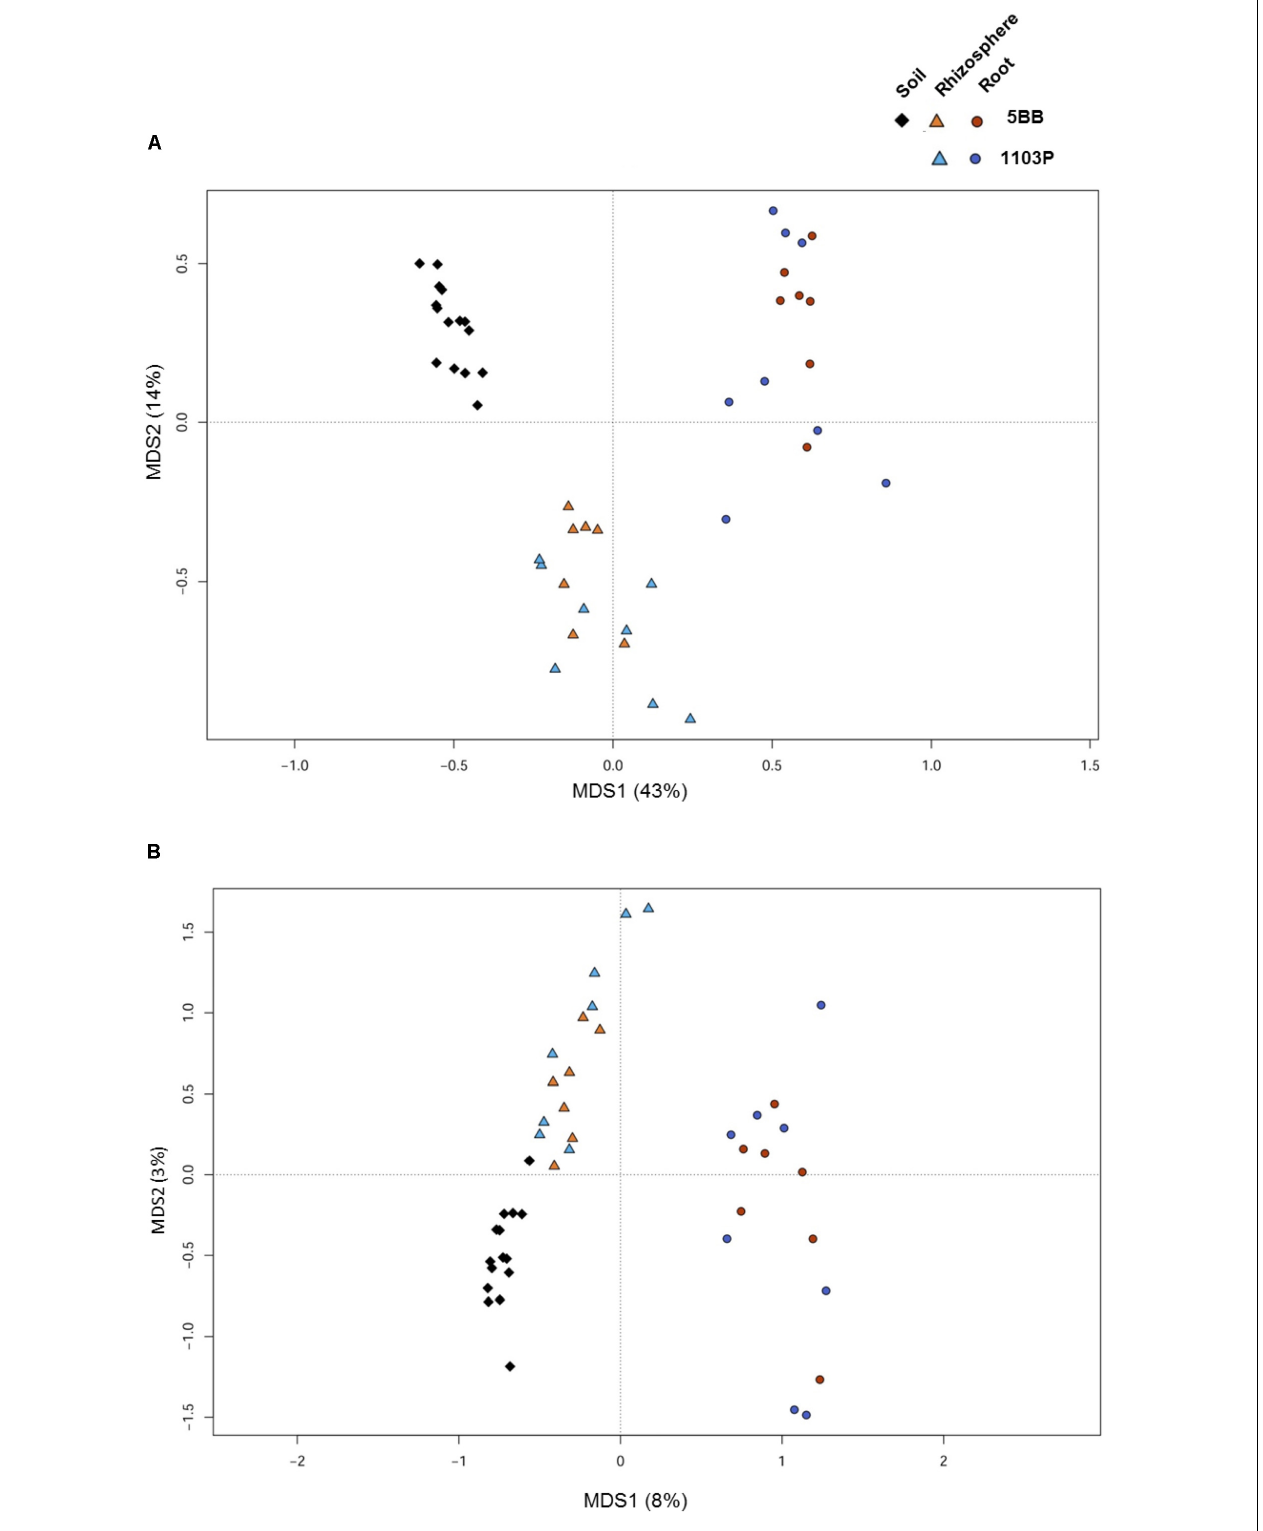
FIGURE 2 | Microbiota community structure in soil, rhizosphere, and root compartments for V. vinifera cultivar Lambrusco grafted onto different rootstocks. Weighted (A) and unweighted (B) UniFrac distance PCoA shows significant segregation among soil (diamonds), rhizosphere (triangles), and root (circles) samples for both V. vinifera 1103P and V. vinifera 5BB. Permutational multivariate ANOVA based on distance matrices (Adonis), P = 0.0001.